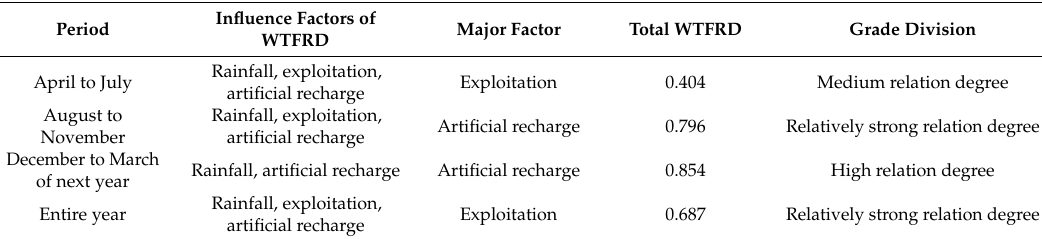
Table 9. Analysis of total WTFRD and its influence